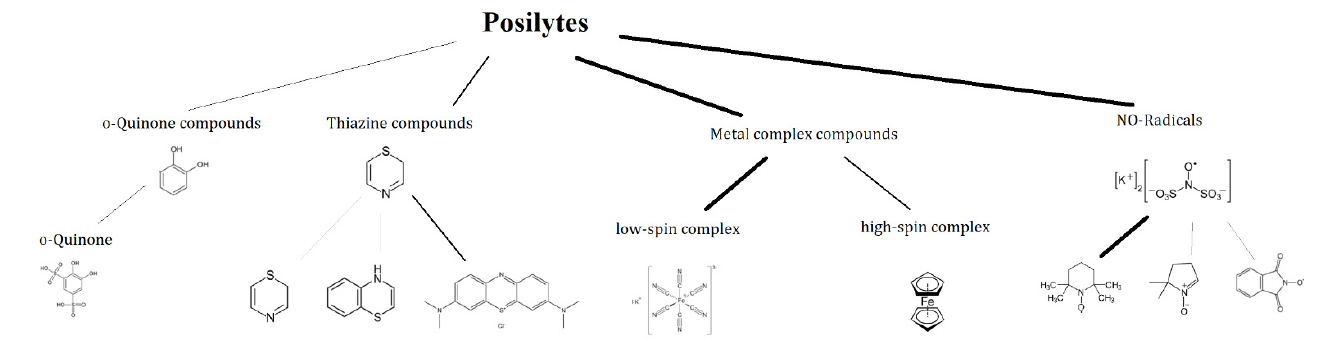
Figure 10. Family tree of the chemical motives for organic redox-active molecules, which could act as posilytes in aqueous organic redox flow batteries. Bigger connecting lines indicate more citations in the literature.